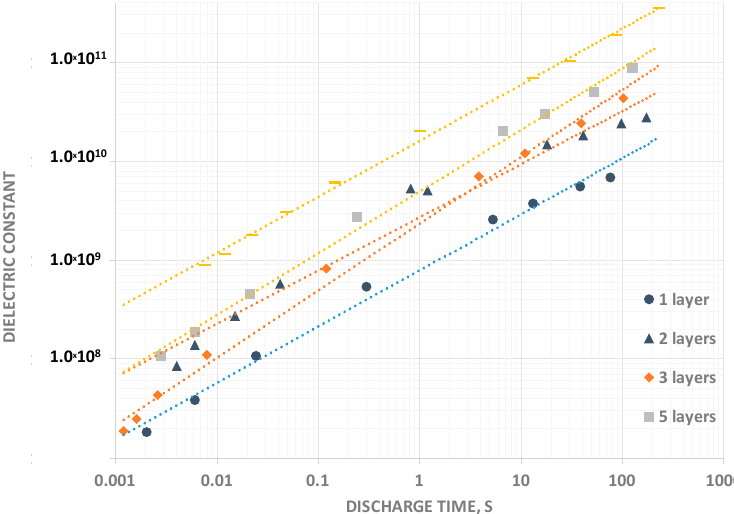
Figure 4. Dielectric Constant vs. Discharge Time. In all cases, even for discharge times of order 0.001 s, the measured dielectric constant was >10 7 . At relatively long discharge times, >100 s, the dielectric constants were, remarkably, >10 10 in all cases.